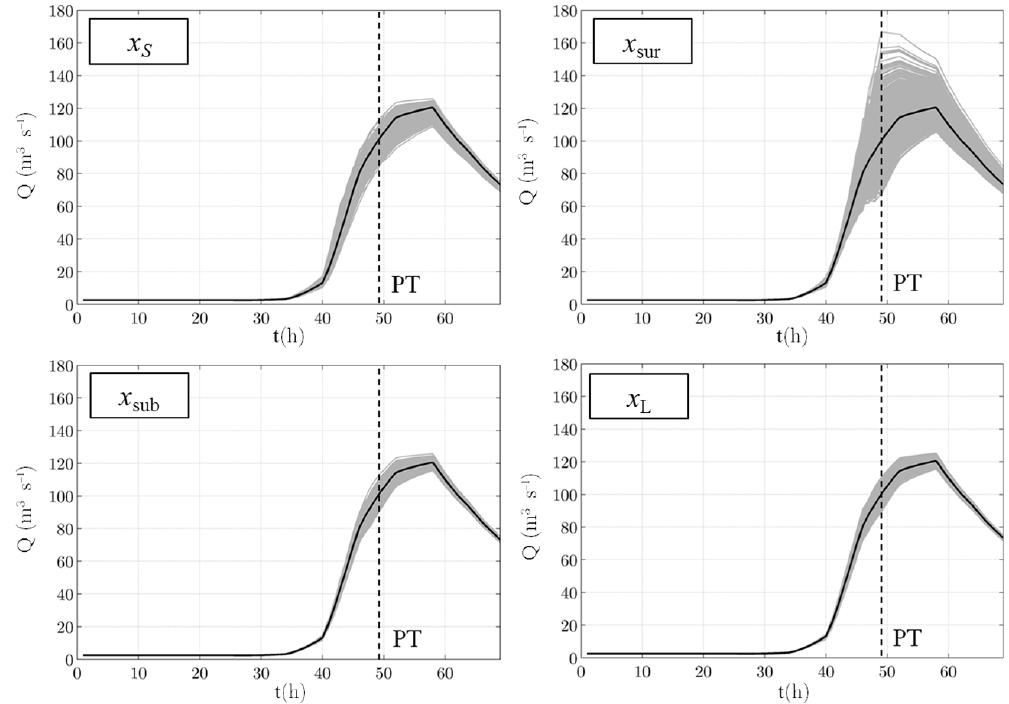
Figure 14. Effect of model state perturbation on the model output for the Bacchiglione catchment: PT indicates perturbation time; x s indicates model state related to S w ; x sur indicates model state related to Q sur ; x sub indicates model state related to Q sub ; x L indicates model state related to Q g